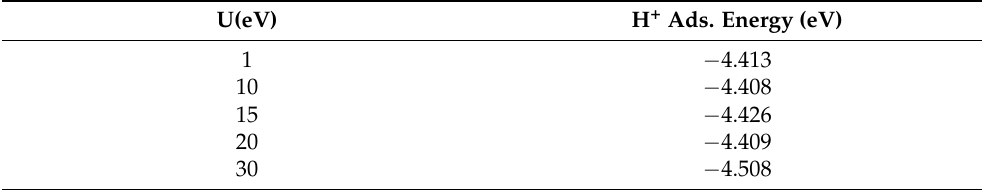
Table 6. H + Adsorption energies inside (16,0) CNT.